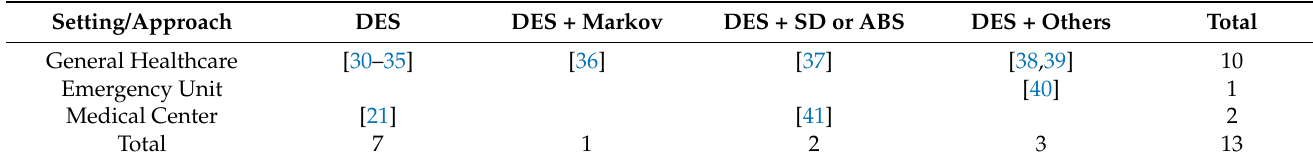
Table 2. Discrete-event simulation review papers in the